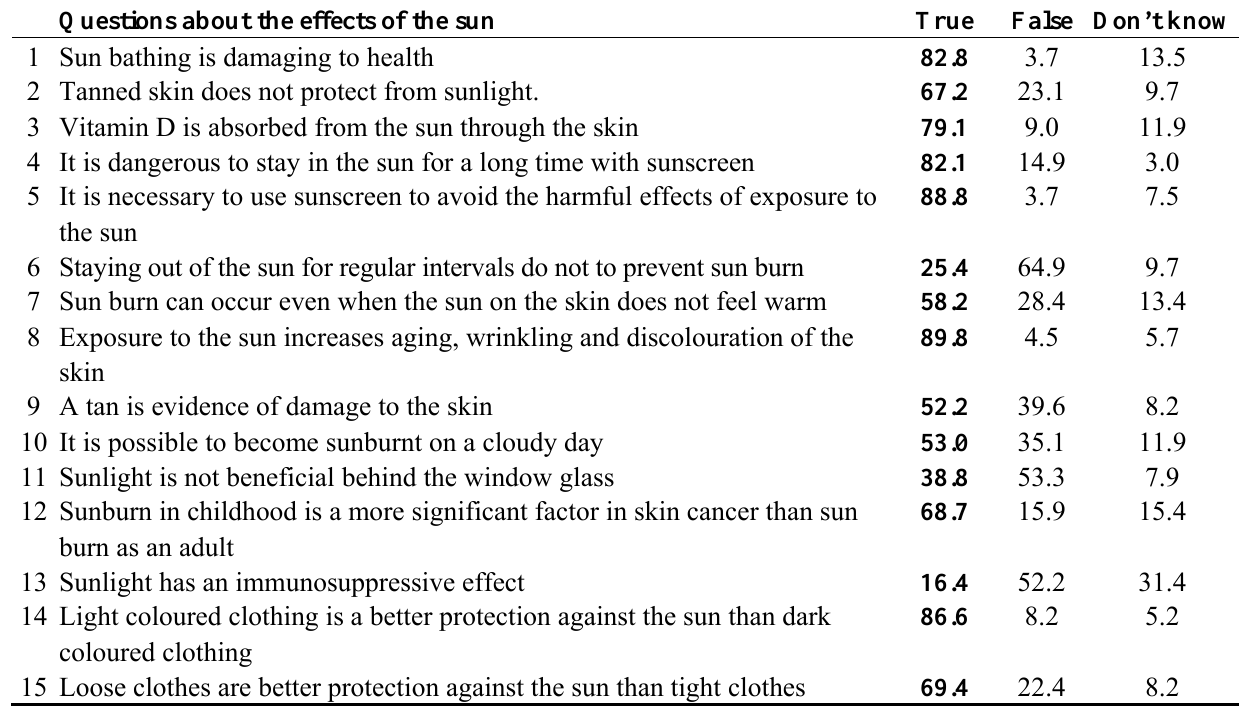
Table 4. A breakdown of student responses to questions